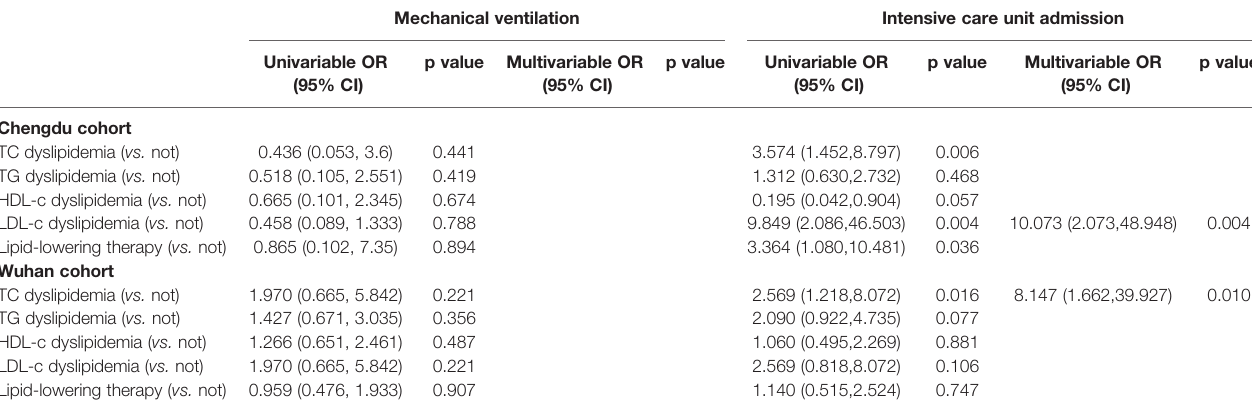
TABLE 4 | Risk factors before admission associated with the secondary endpoint after